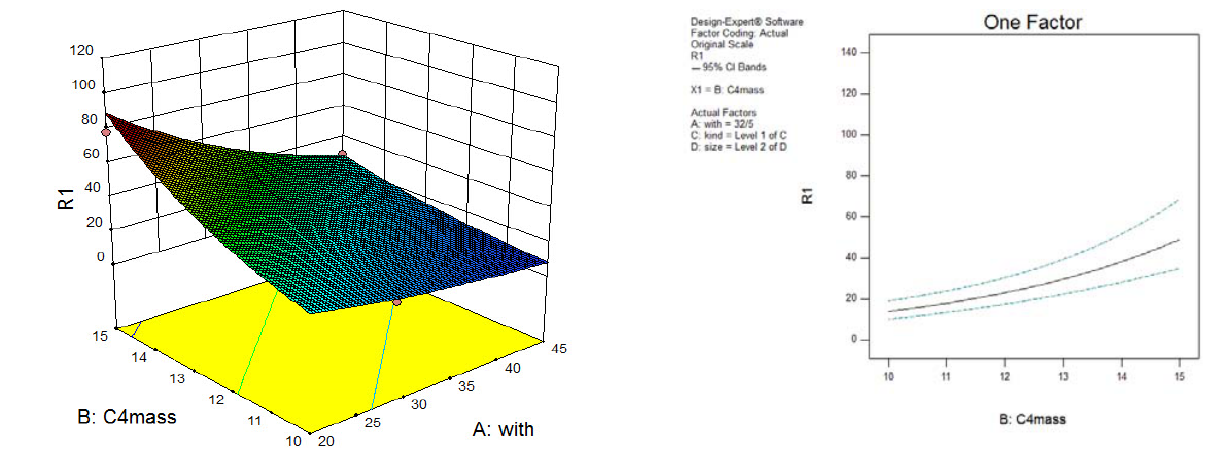
Figure 30: 3D graph for almond pumice. Figure 31: Displacement changes by changing the blast charge for almond pumice.